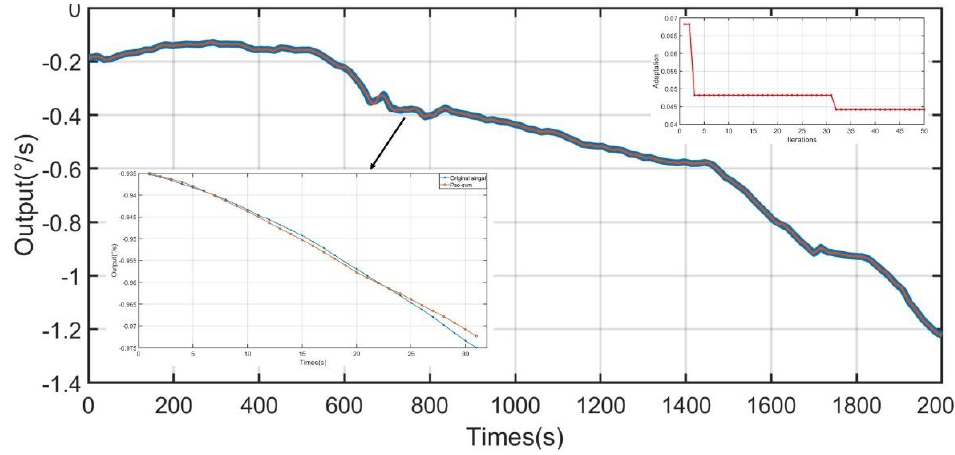
Figure 20. Temperature noise denoising based on PSO-SVM (60 –− 40 °C).